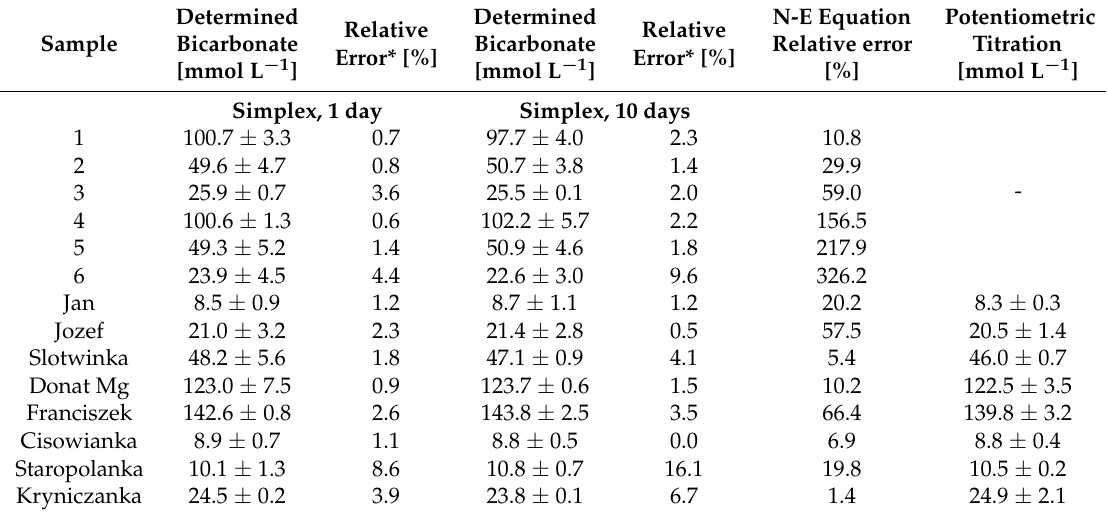
Table 5. Results of determination of bicarbonate